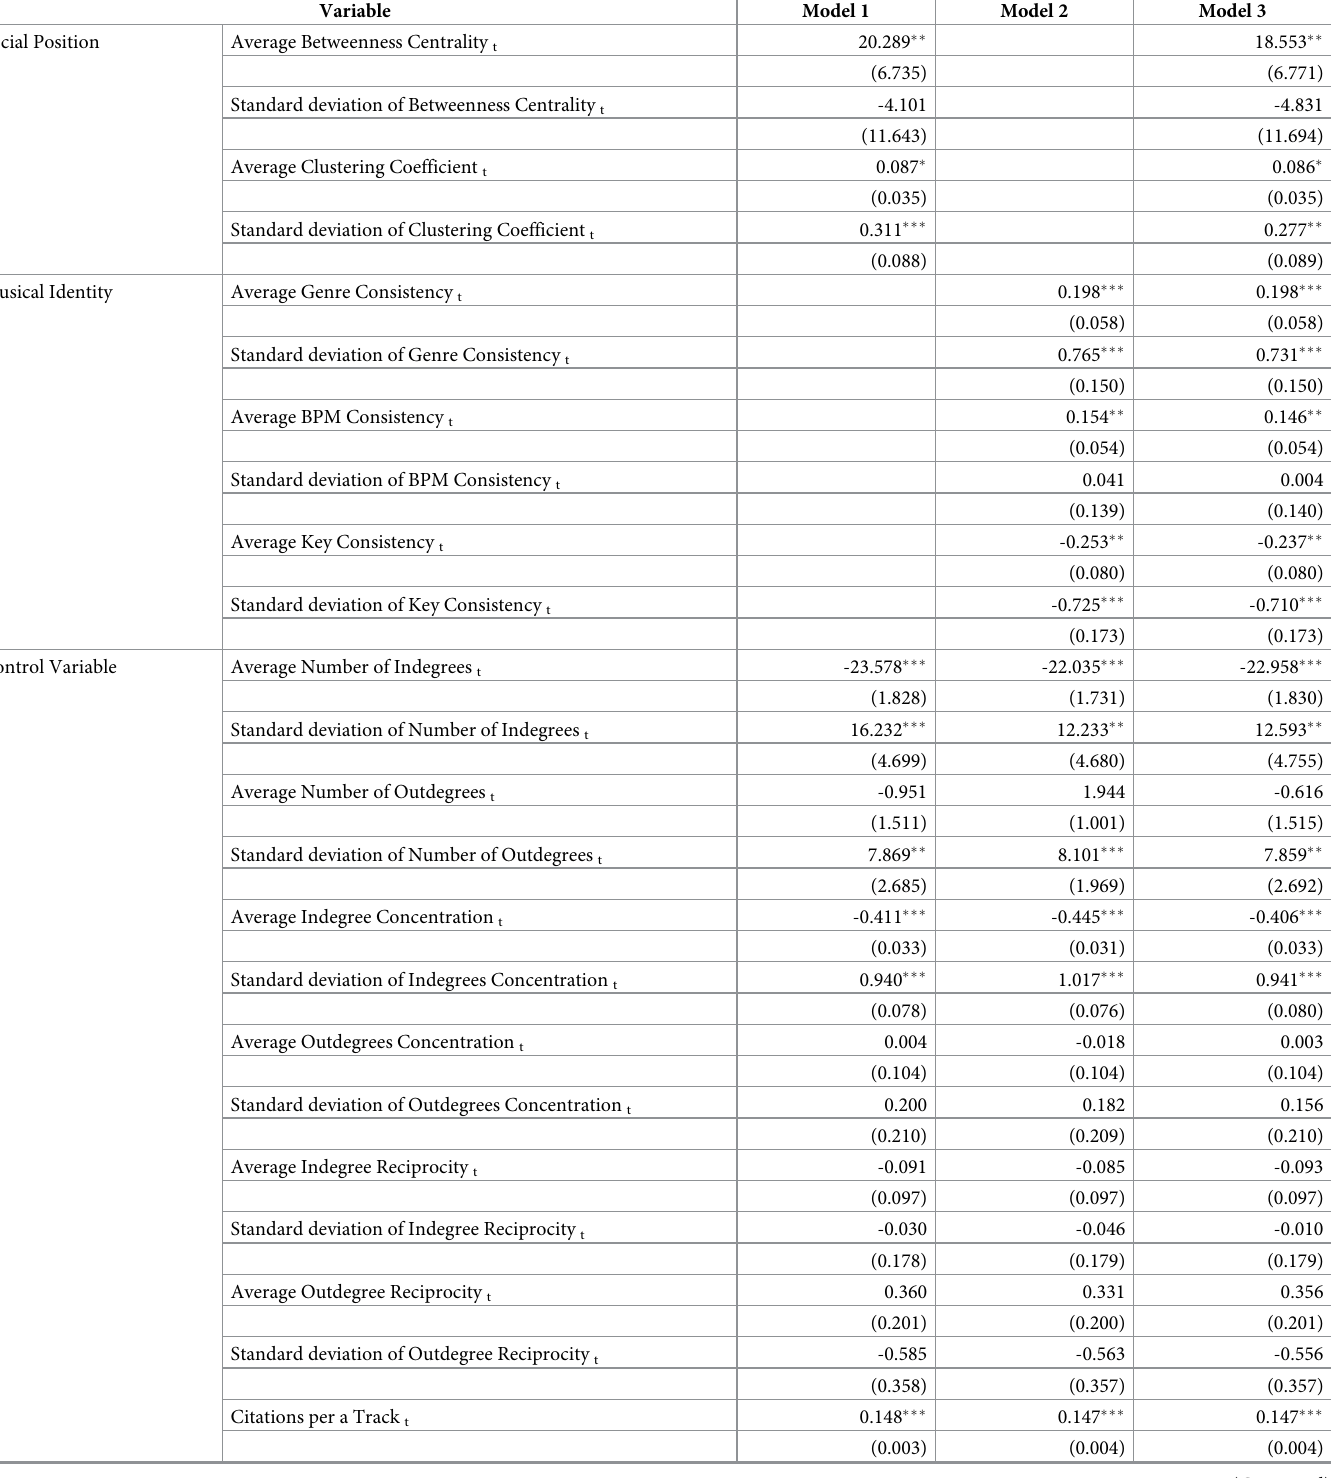
Table 3. Negative binomial regressions predicting the number of citations per track t+1 (CEM